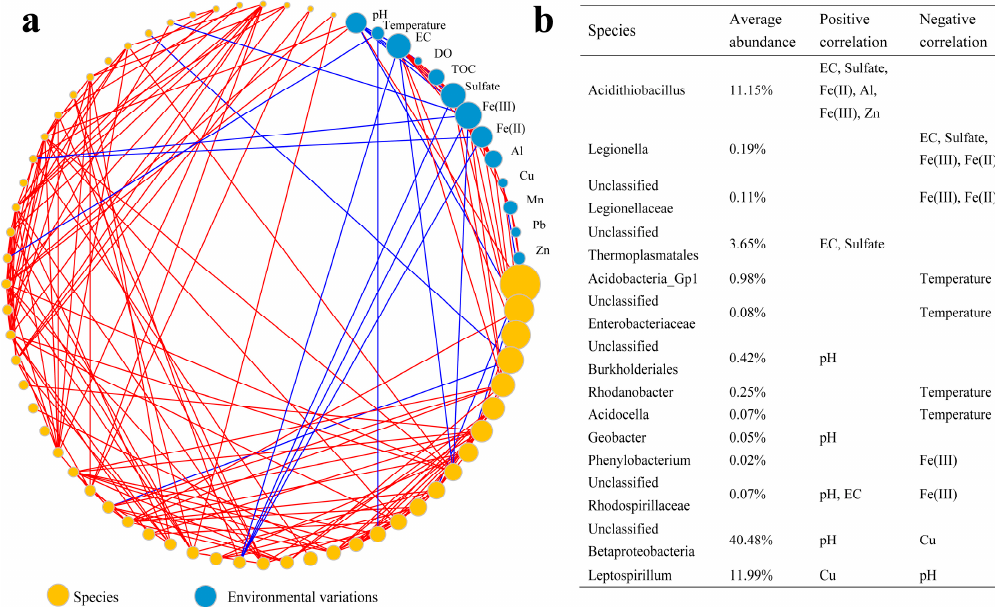
Figure 4. Correlation network ( a ) visualizing pairwise correlations between environmental variations and species at the order level, and selected species ( b ) with the highest correlated response to environmental variations. Data obtained from 59 AMD samples in 14 mining areas across South China were utilized to build the network (data from [24]). Each edge stands for a considerable (Spearman’s ρ > 0.45 or ρ < − 0.45) and significant ( p -value < 0.05) correlation. The different colors indicate positive (red) and negative (blue) correlations. The size of each node is proportional to the average relative abundance (species) or the sum of correlation coefficients (environment variations).